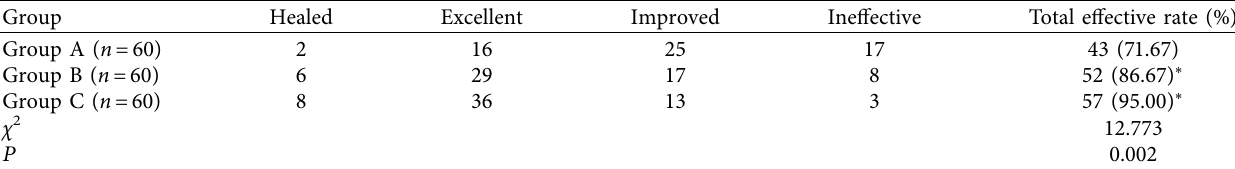
Table 2: Comparison of 3 groups of DHI score treatment efficiency ( n (%)).